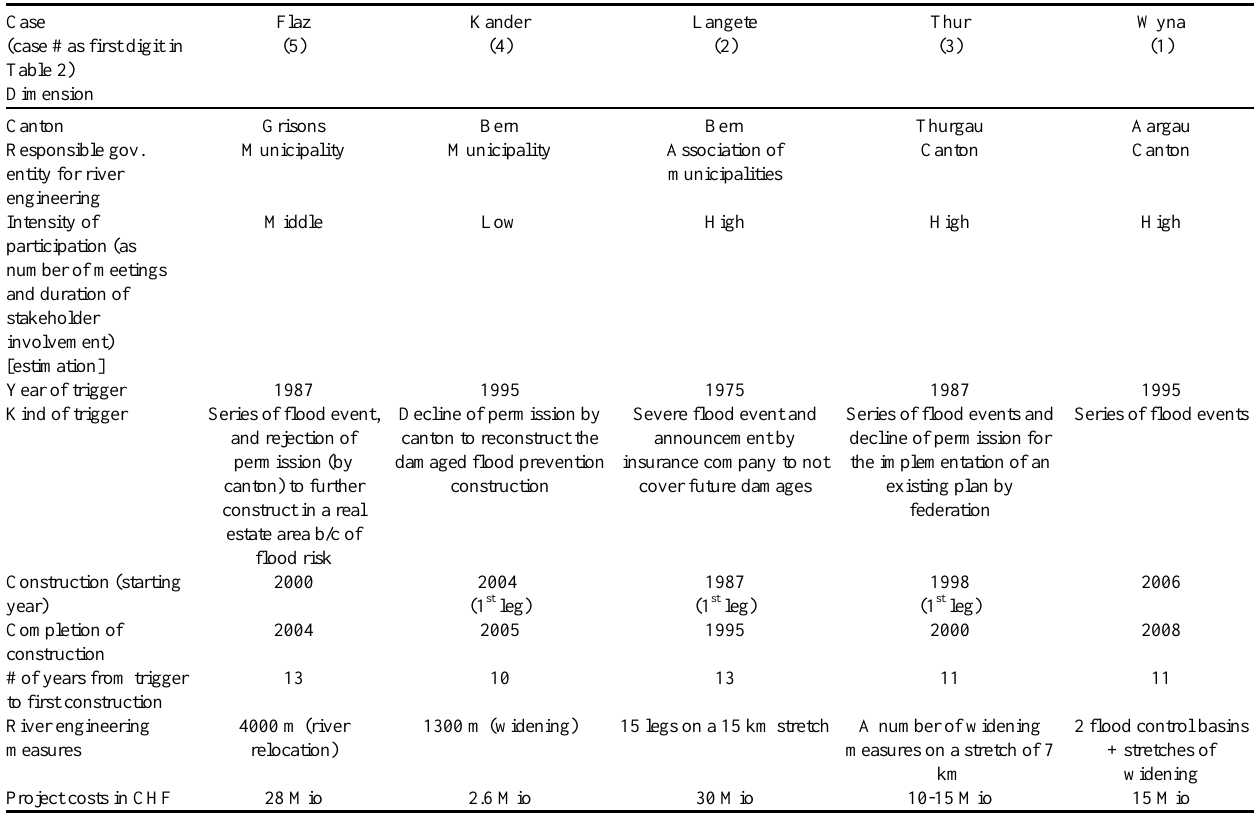
Table 1 . Characteristic information of the cases